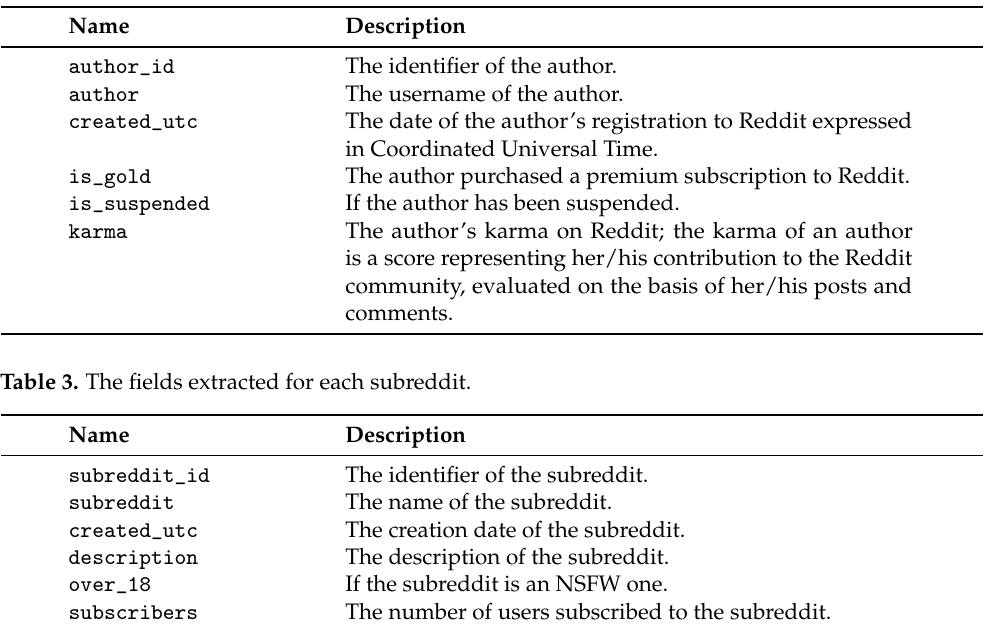
Table 2. The fields extracted for each author.